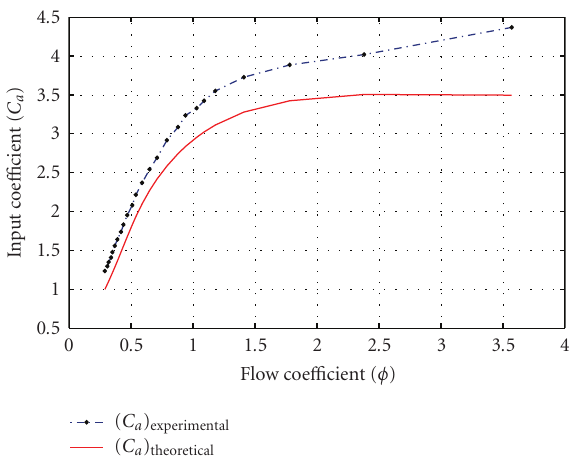
Figure 8: Turbine e ffi ciency versus flow coe ffi cient